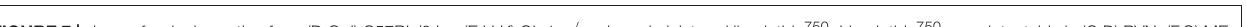
FIGURE 7 | views of a single section from (D,G,J) C57BL/6J or (E,H,K) Glp1r − / − mice administered liraglutide 750 . Liraglutide 750 was detectable in (C,D) PVN, (F,G) ME and ARC, and (I,J) AP. (E,H,K) In mice lacking a functional GLP-1R, no liraglutide 750 signal could be detected in any of these regions. Scale bars: 200 µ m (A,B,C,F,I); 50 µ m (D,E); 100 µ m (G,H,J,K). (B) The brain tissue was scanned at 620 and 710nm, representing both autofluorescence from the tissue (gray) and specific signal (green). The red regions in (A,D,G,J) are shown at higher magnification in (B,E,H,K), respectively (unspecific staining has been removed). Images in the middle and right columns represent enlargements of a single section from (B,E,H,K) C57BL/6J or (C,F,I,L) Glp1r − / − mice administered with liraglutide 750 . Liraglutide 750 was detectable in (A,B) organum vasculosum of the lamina terminalis (D,E), subfornical organ (G,H), supraoptic nucleus and supraoptic decussation, and (J,K) ChP. (C,F,I,L). In mice lacking a functional GLP-1R, no liraglutide 750 signal could be detected in any of these regions except from ChP. Scale bars: 200 µ m (A,D,G,J–L); 100 µ m (B,C,E,F,H,I). AP, area postrema; ARC, arcuate nucelus; ChP, choroid plexus; ME, median eminence; NTS, nucleus of the solitary tract; OVLT, organum